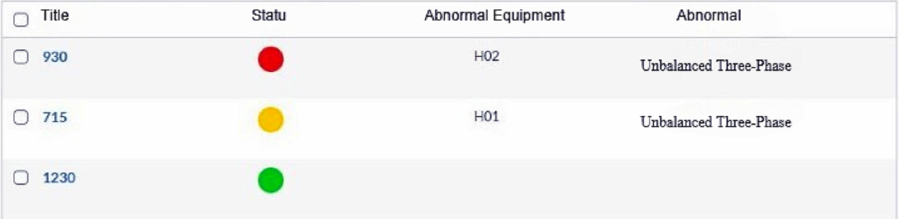
Figure 3. Current Monitoring System.